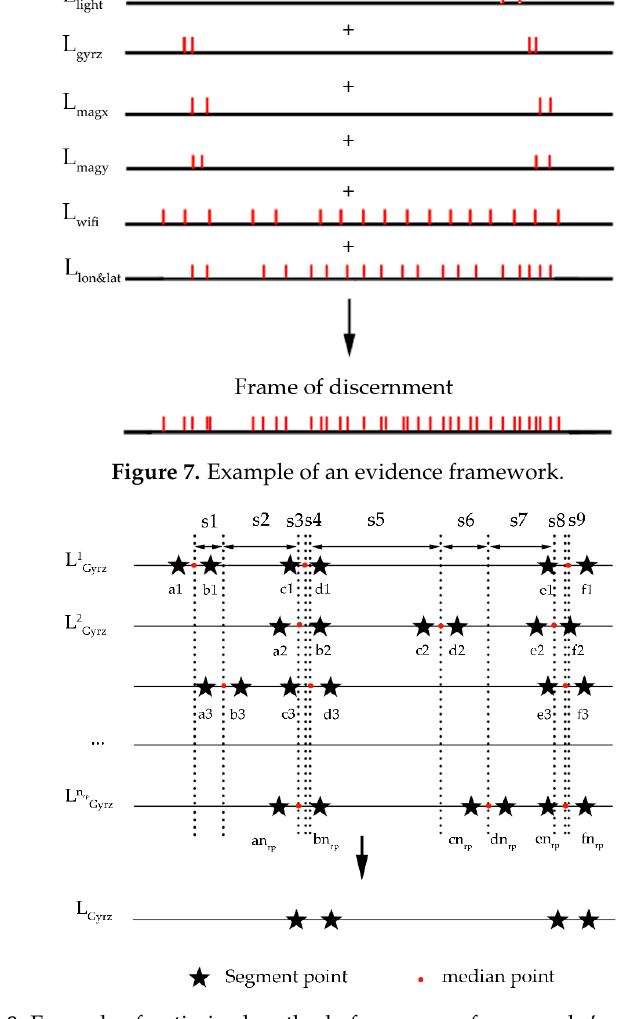
Figure 8. Example of optimized method of gyroscope frameworks’ segmentation.